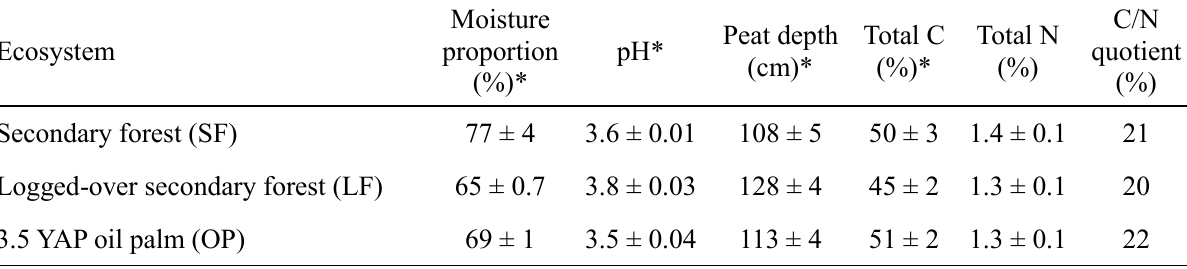
Table 1. Physico-chemical characteristics of soil in the three Alan Bunga peat swamp forest ecosystems. Data are presented as mean ± standard error of mean (SEM). Asterisks indicate variables that differed significantly between ecosystems (non-parametric Kruskal-Wallis ANOVA; n = 3, P < 0.05). YAP = years after